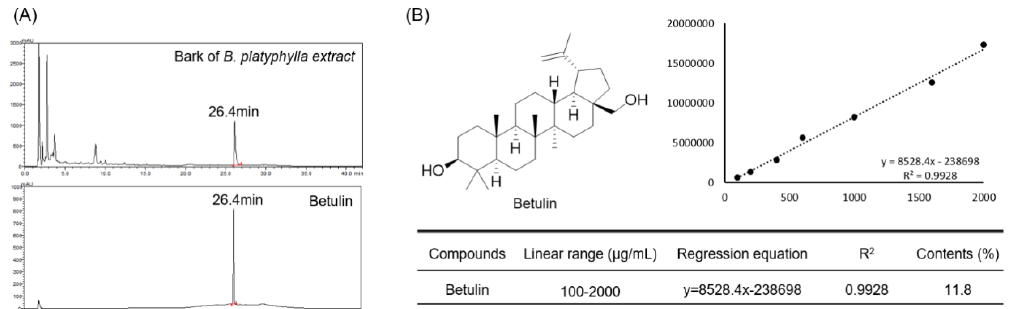
Figure 1. Quantitative analysis of Betulin in bark of B. platyphylla extract. And analysis of bark of B. platyphylla extract and betulin using HPLC DAD ( A ). Diode array detector wavelength (203 nm). Confirmation of linearity of isolated betulin and analysis of betulin content in bark of B. platyphylla extract ( B ).